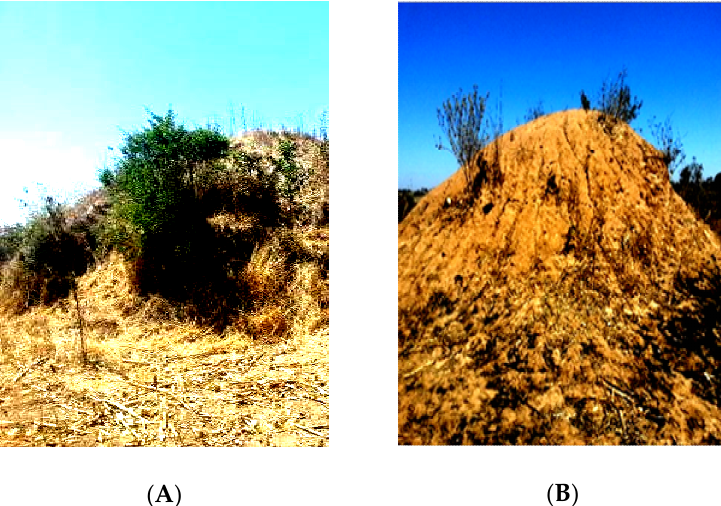
Figure 3. ( A ) Termite mound with vegetation cover is an indicator of good fertility; ( B ) termite mound with no or little vegetation cover depicts poor fertility and is never utilized for agricultural production as part of low input nutrient management strategy by smallholder farmers in Southern Zambia. Indigenous knowledge is normally applied by the mound soil users to identify suitability in crop production [7].